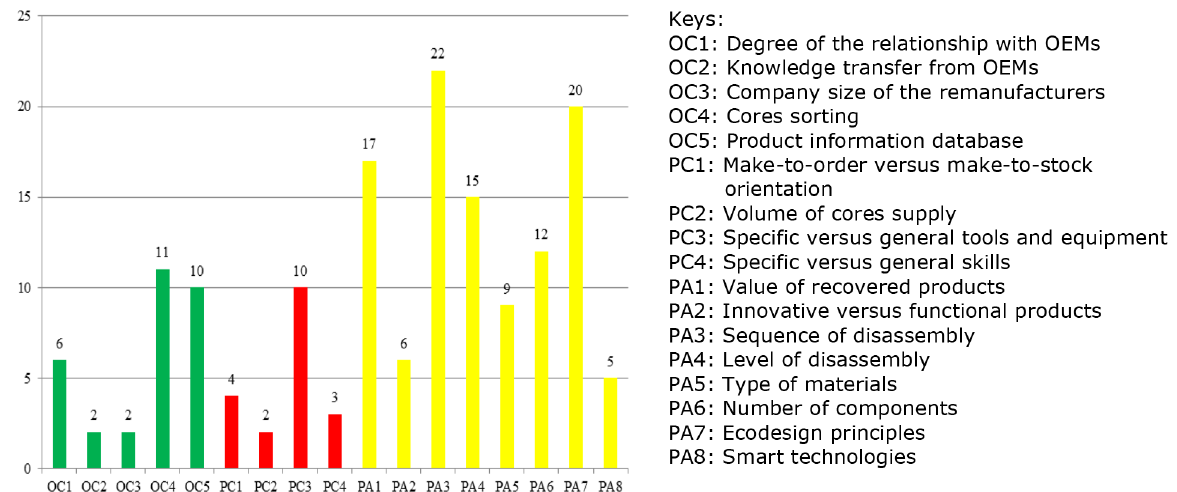
Figure 3. Factors affecting disassembly identified from the literature